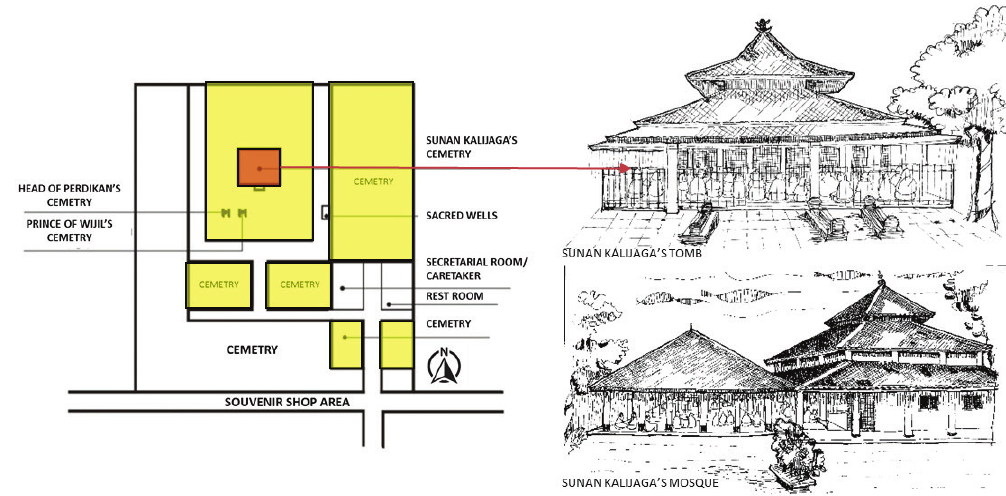
Figure 11. Some sacred seats in the traditional ritual of Sunan Kalijaga’s cemetery (left), (right) above is Sunan Kalijaga’s tomb and below is Sunan Kalijaga’s mosque (source: Survey, 2017)